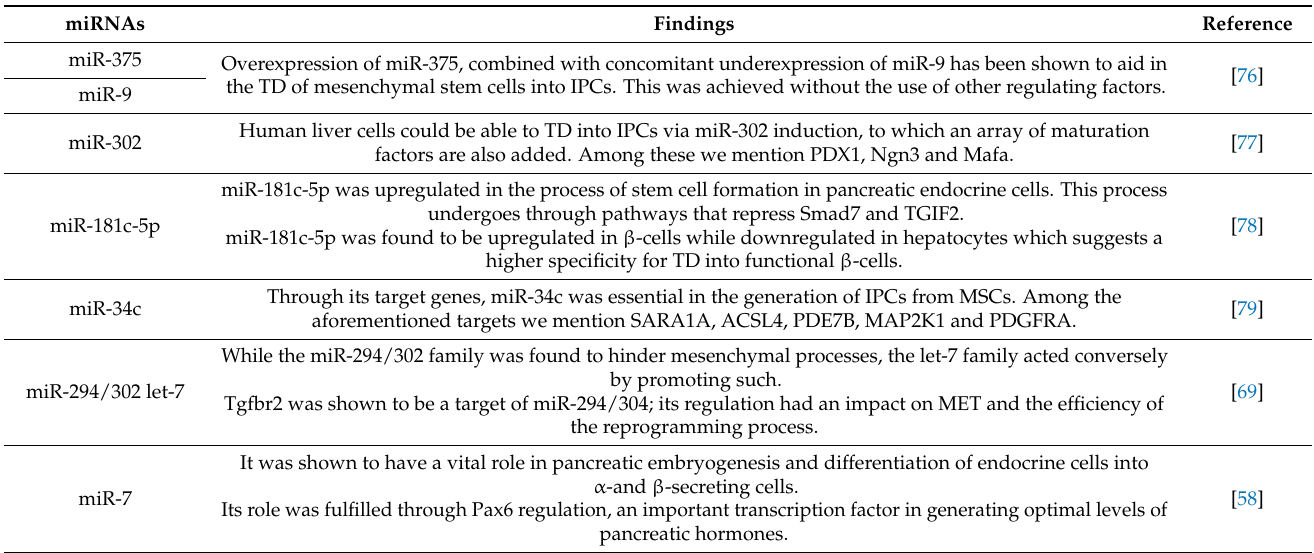
Table 2. miRNAs involved in different organs’ TD process into